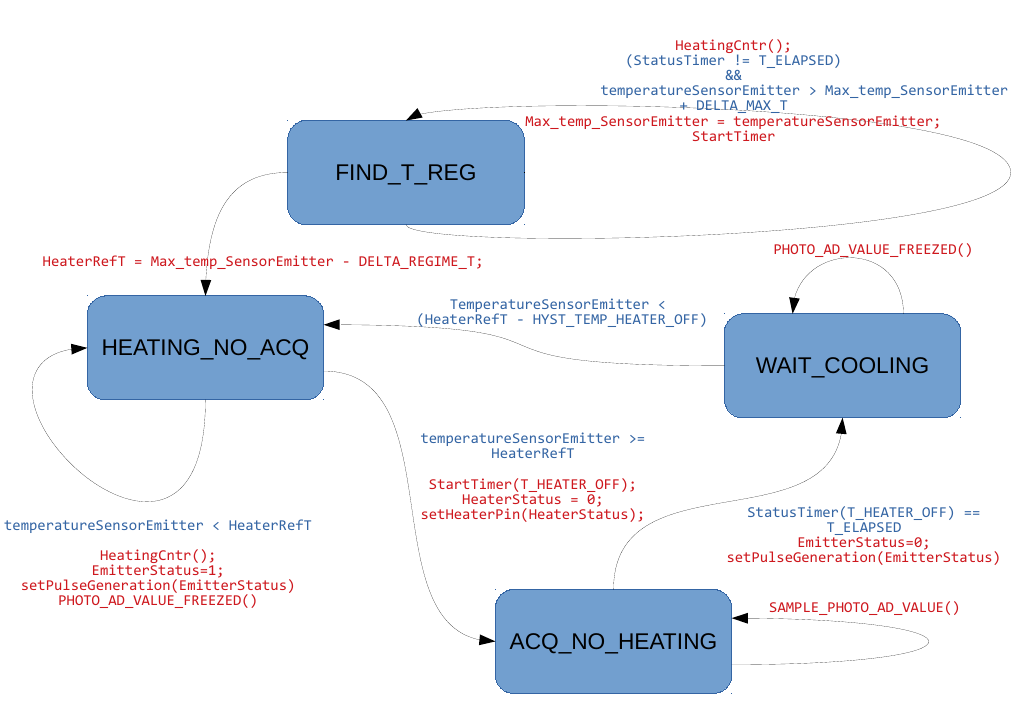
Figure 13. State diagram of Temperature Control Algorithm.